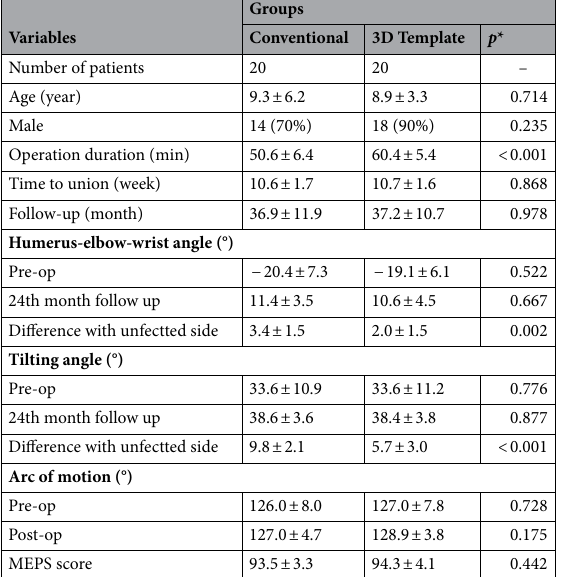
Table 1. Comparisons between conventional and 3D printing template groups. *Mann–Whitney U test and Fisher’s exact test.